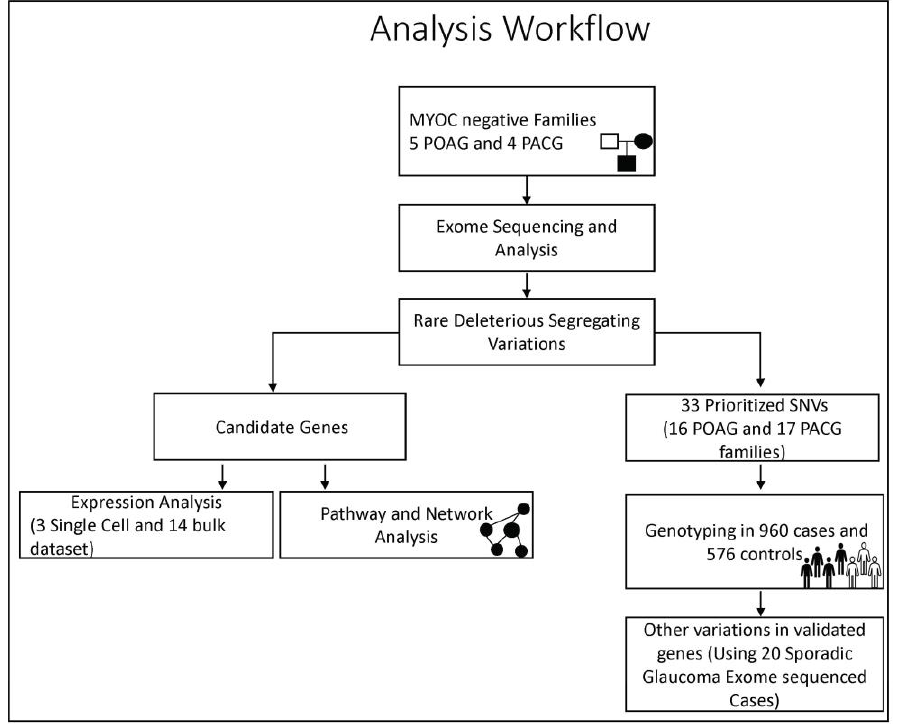
Figure 1. The workflow depicting the study design and analysis strategy adopted in the study